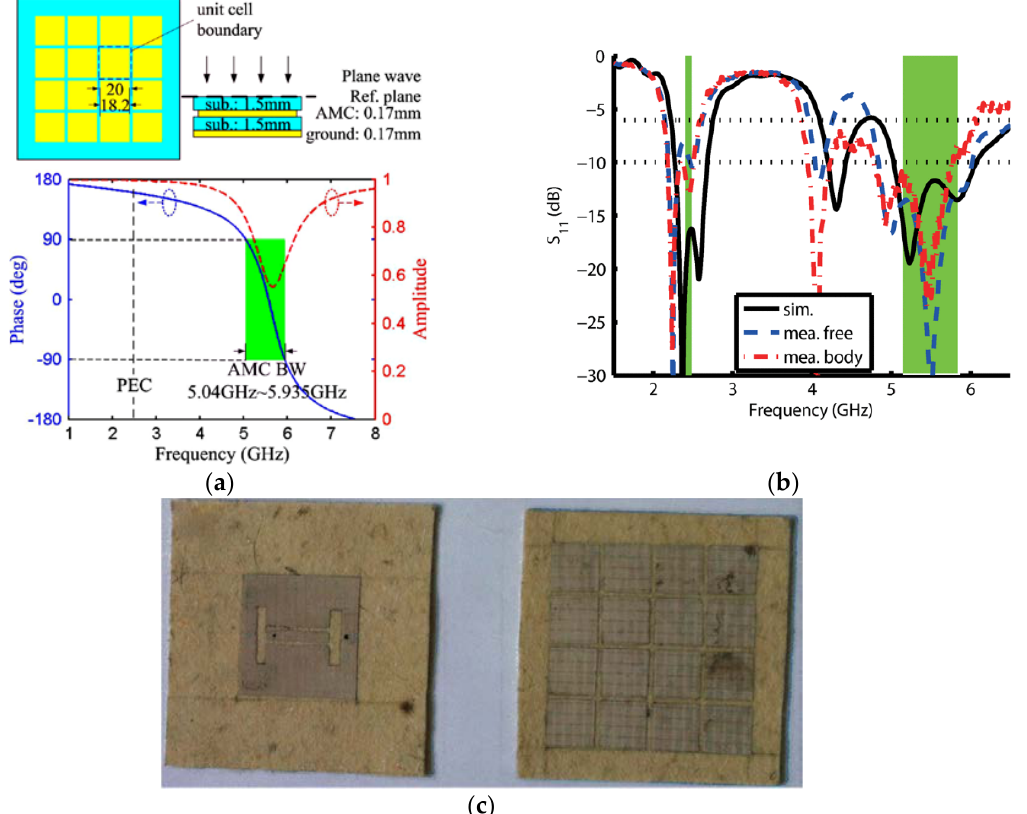
Figure 11. A low-profile dual-band textile antenna with artificial magnetic conductor plane [102]. ( a ) The AMC plane of the antenna and its reflection phase. ( b ) S11 curves of the dual-band antenna in free space and on the human body. ( c ) The photo of the wearable antenna.